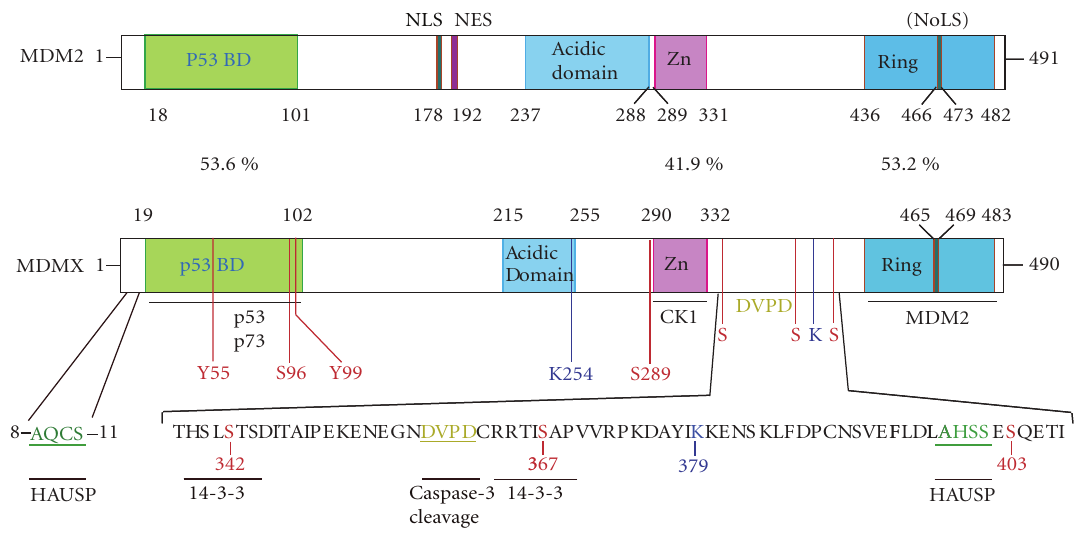
Figure 1: Schematic representation of MDMX protein structure in comparison with MDM2. Most indicated protein modification sites and protein-protein interactions shown are discussed in the text. Modifications of MDMX by sumoylation (K254, K379) have not yet shown to a ff ect function or regulation of MDMX [5]. Phosphorylation of S298 stimulates the association of MDMX to p53 [6], and phosphorylation of S96 has been reported to a ff ect the regulation of subcellular localization of MDM2 [7].